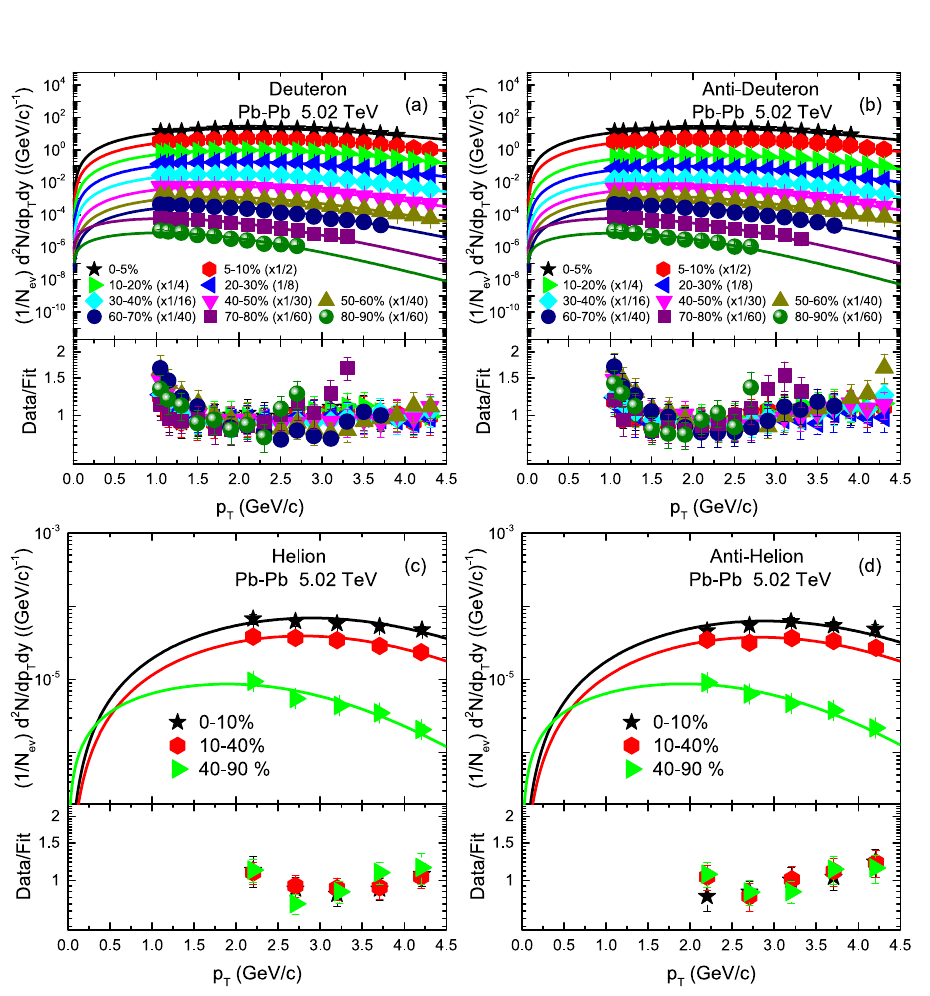
¯ d ¯ He , 3 He and 3 in | y | < 0.5 produced in different centrality